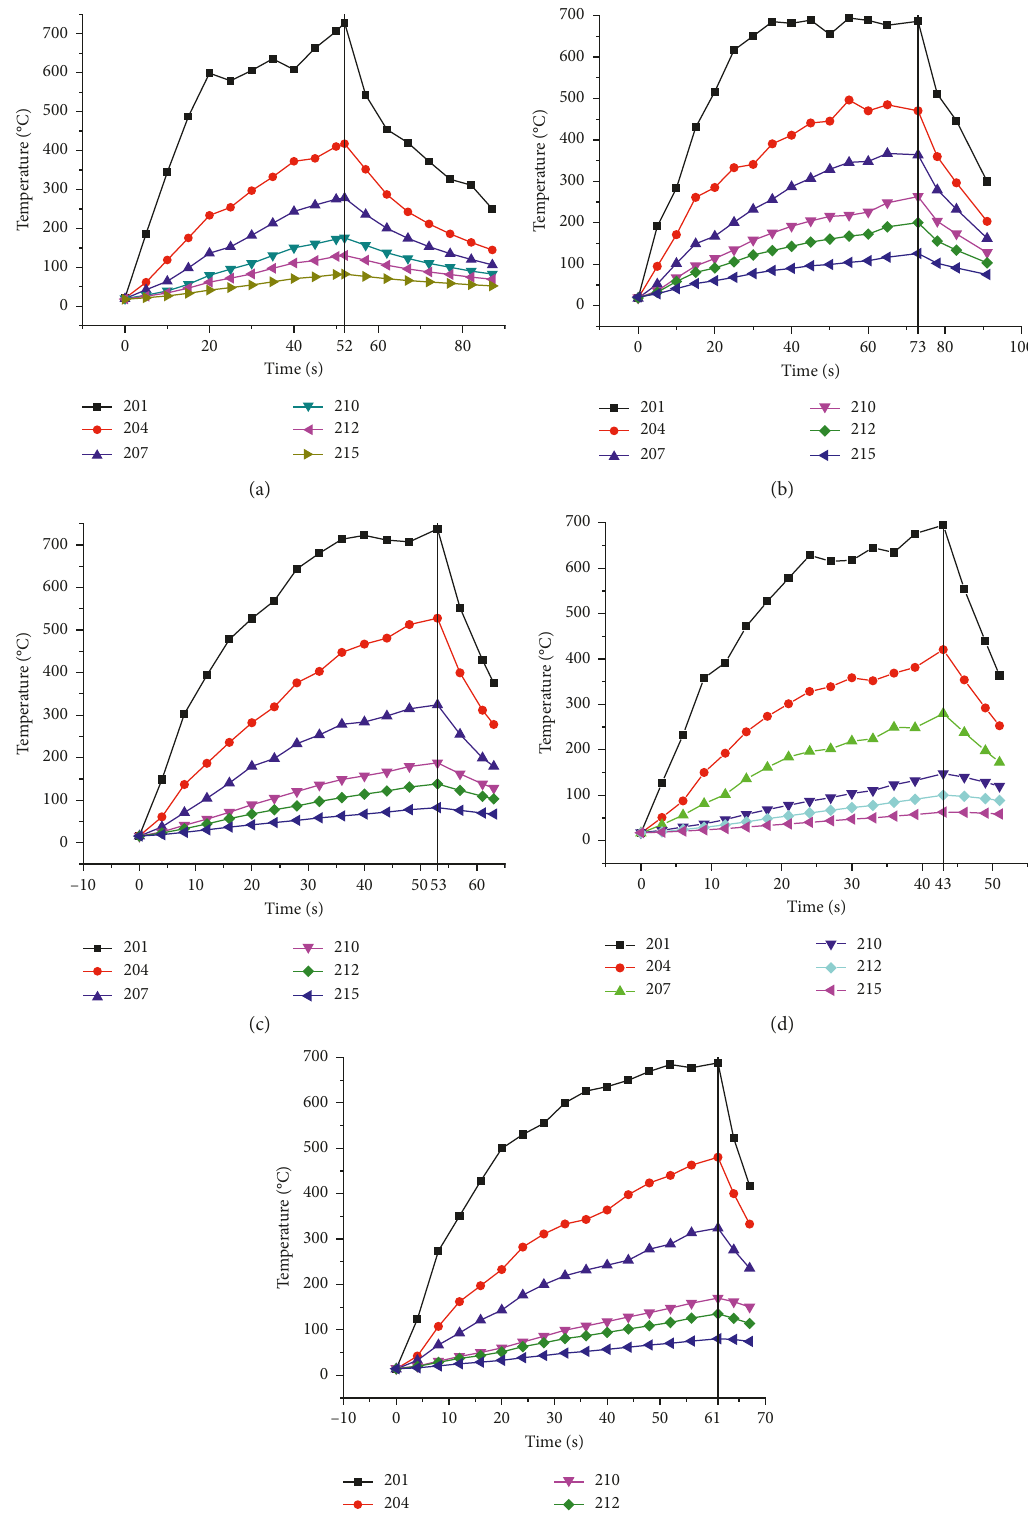
Figure 4: (a–e) Temperature field under different injection pressures. (a) 0.1MPa. (b) 0.2 MPa. (c) 0.4MPa. (d) 0.6MPa. (e)